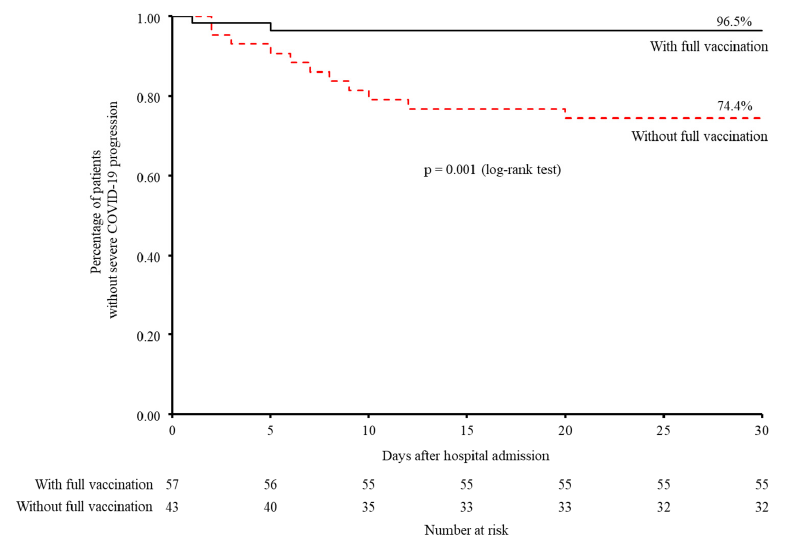
Figure 1. Percentage of patients without progression to severe COVID-19 stratified by vaccination status estimated by the Kaplan–Meier method. Abbreviations: COVID-19, coronavirus disease 2019.